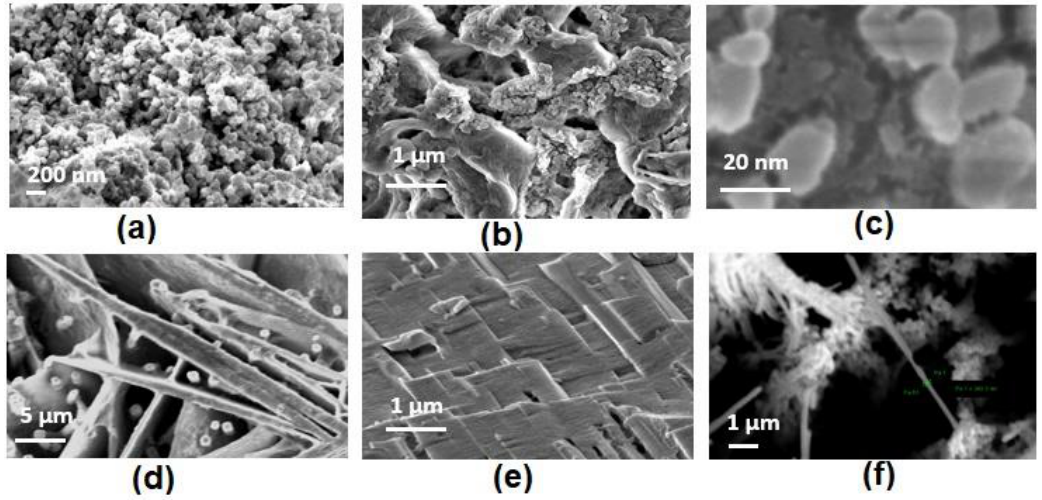
Figure 7. FESEM micrograph of randomly oriented multiple nanostructures at potential of − 3.2 V ( a ) top view of the AAO template; ( b ) high resolution of the ( a ); ( c ) high resolution image of ( b ) showing a cluster of nanoparticles; ( d ) formation of nanoplates and nanoparticles inside the template at few locations, tilted view of ( d ); ( e ) a close view of the nanoplates in ( d ); and ( f ) formation of random nanorods of uneven thickness.